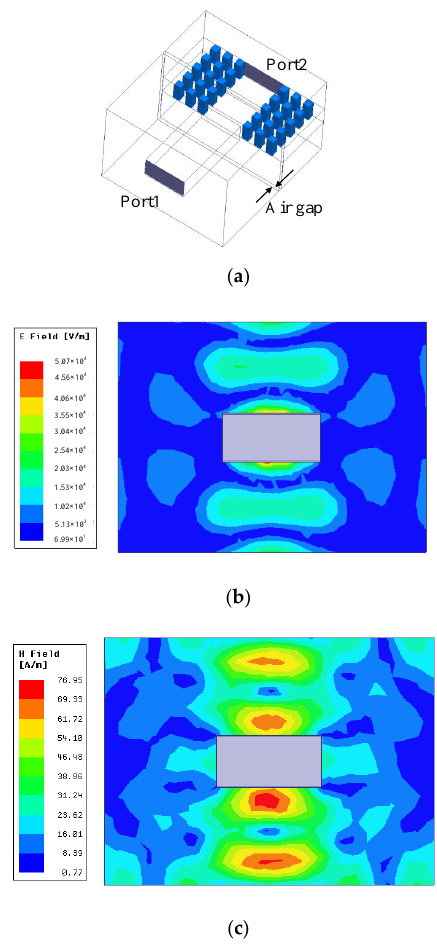
Figure 6. Analysis of the effects of wave polarization. ( a ) A single rectangular waveguide (RW)-to-groove gap waveguide (GGW) transition model; ( b ) electric field distribution of the air gap plane at 110 GHz; ( c ) magnetic field intensity of the air gap plane at 110 GHz.